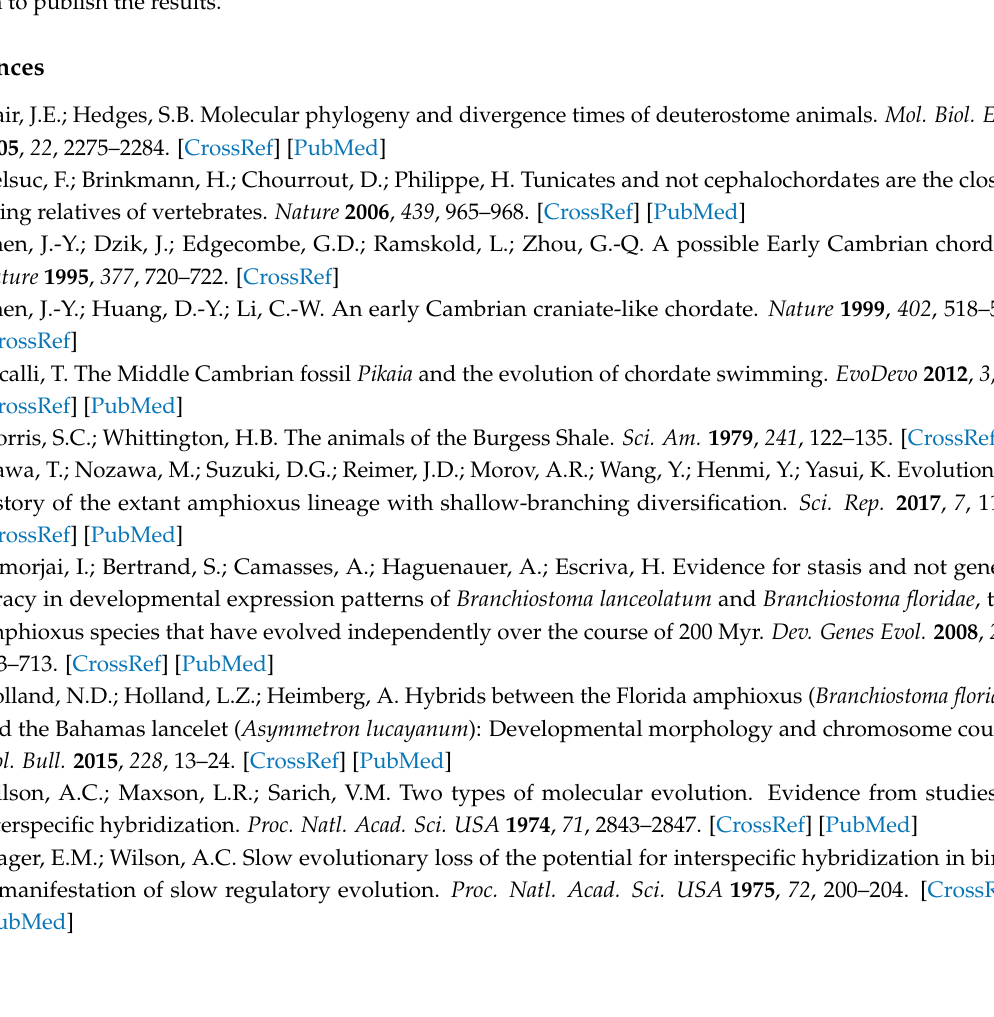
Table S1: Comparison of the domain architectures of randomly selected lancelet proteins with those of their human Swiss-Prot orthologs, Table S2: Comparison of the domain architectures of key developmental proteins of lancelets with those of their human Swiss-Prot orthologs, Table S3: Comparison of the domain architectures of randomly selected lancelet proteins with novel domain